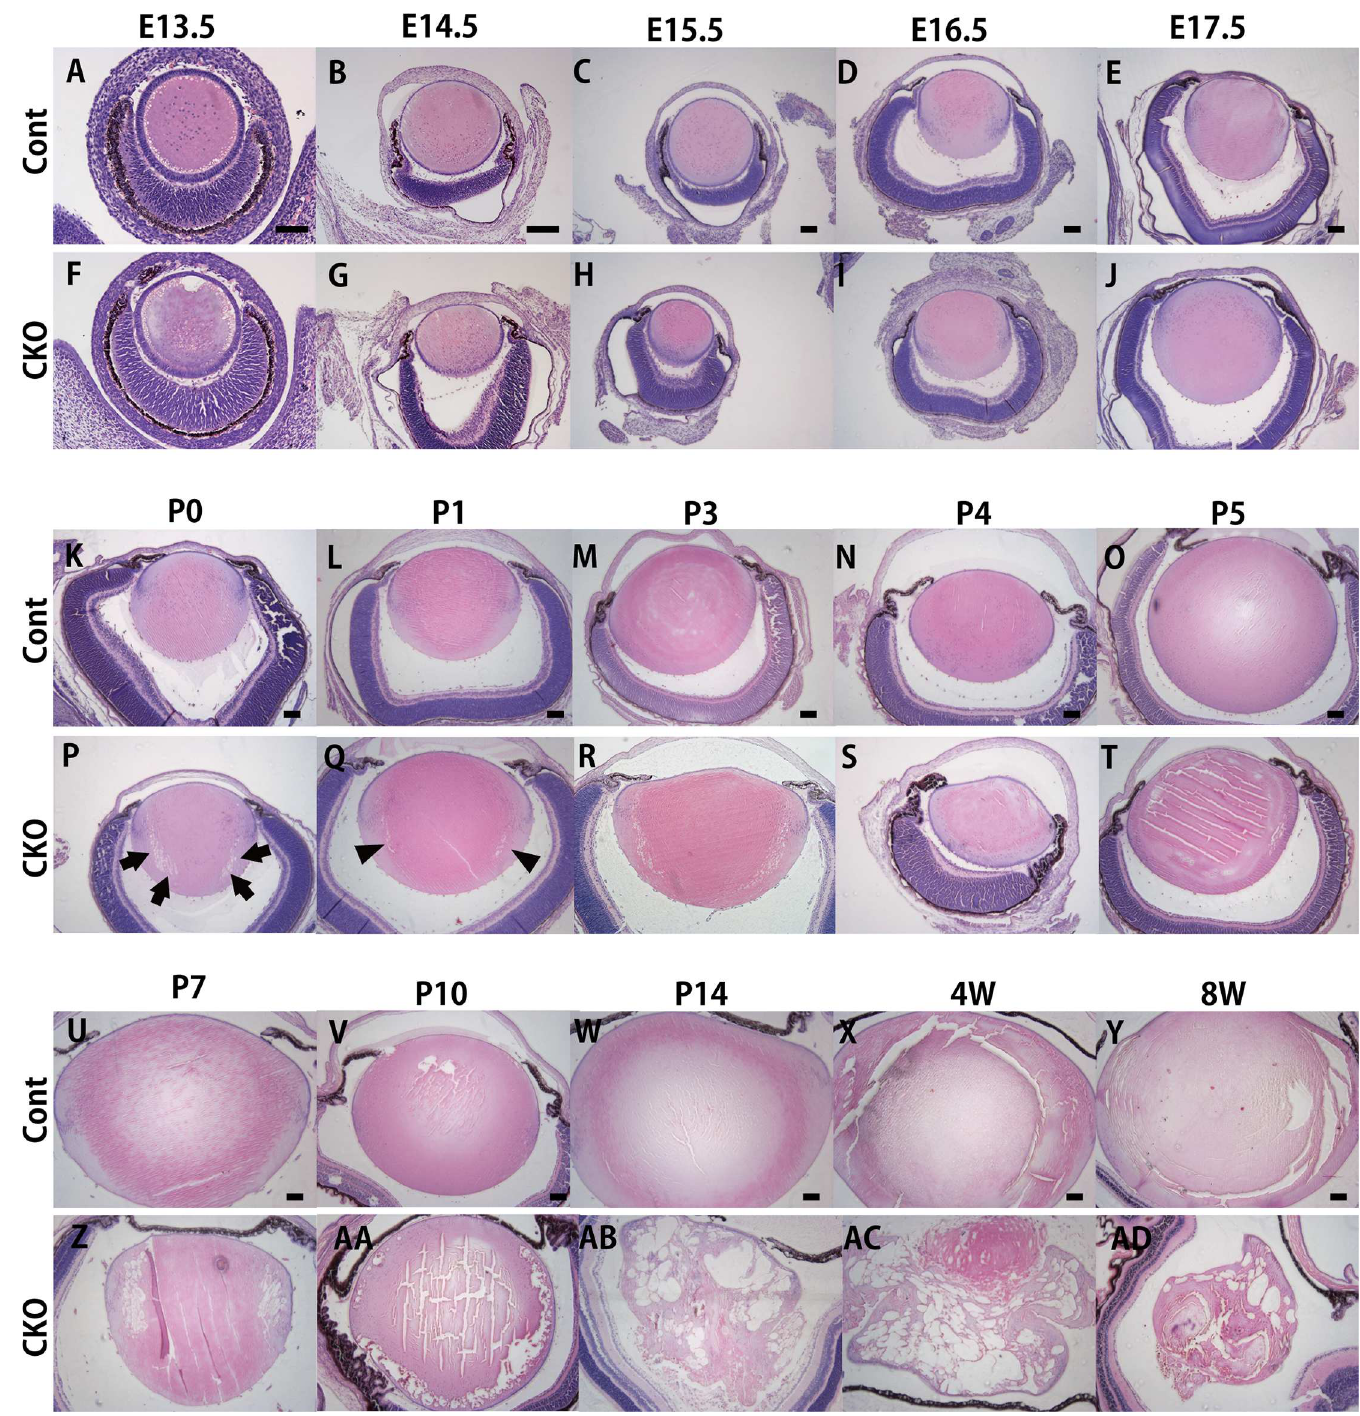
Fig 2. The sequential histologyof the lens at the indicatedtime pointsin Rest CKO mice and theircontrol littermates. Lenses at E13.5 (A, F), E14.5 (B, G), E15.5 (C, H), E16.5 (D, I), E17.5 (E, J), P0 (K, P), P1 (L, Q), P3 (M,R), P4 (N, S), P5 (O, T), P7 (U, Z), P10 (V, AA), P14 (W, AB), 4W (X, AC), and 8W (Y, AD) in Rest CKO mice (F-J, P-T, and Z-AD)and their controllittermates(A-E,K-O, and U-Y) were shown. Lenses from Rest CKO adult mice clearly showed an abnormal morphology in the lens cortexand/orbow region,where newly formedsecondarylens fibersare present,by HE staining.Arrows and arrowheadsindicatethe formationof vacuoles and gaps in lens fibers, respectively. Scale bars represent 50 μ m.